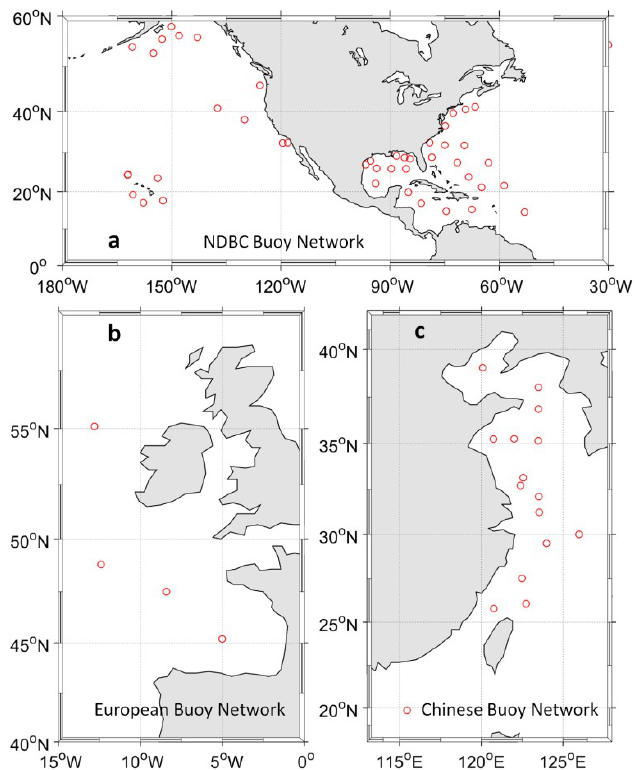
Figure 1. The locations of buoys from the three networks used in this paper. The locations of the NDBC, European and Chinese buoys are indicated in subfigure ( a – c ), respectively.